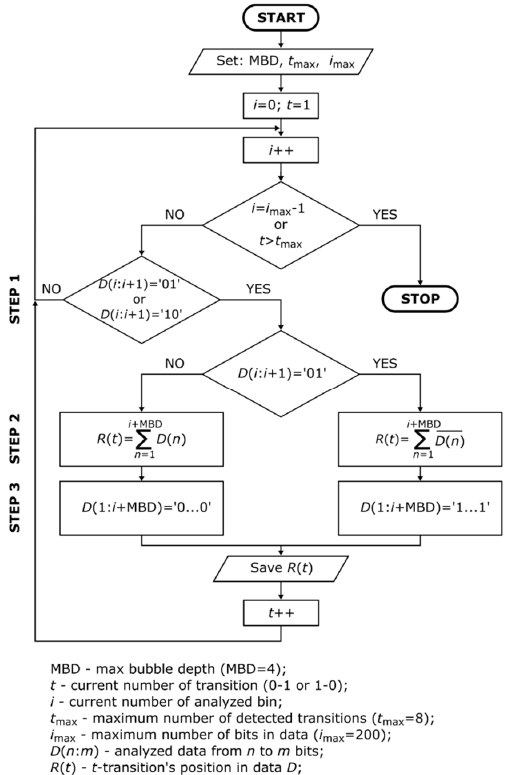
Figure 4. Counter-based pre-encoder algorithm: Step 1—finding transitions 0-1 or 1-0; Step 2— counting the number of logic states “0” or “1” in a selected range; Step 3—modification of the input data to search for another transition.